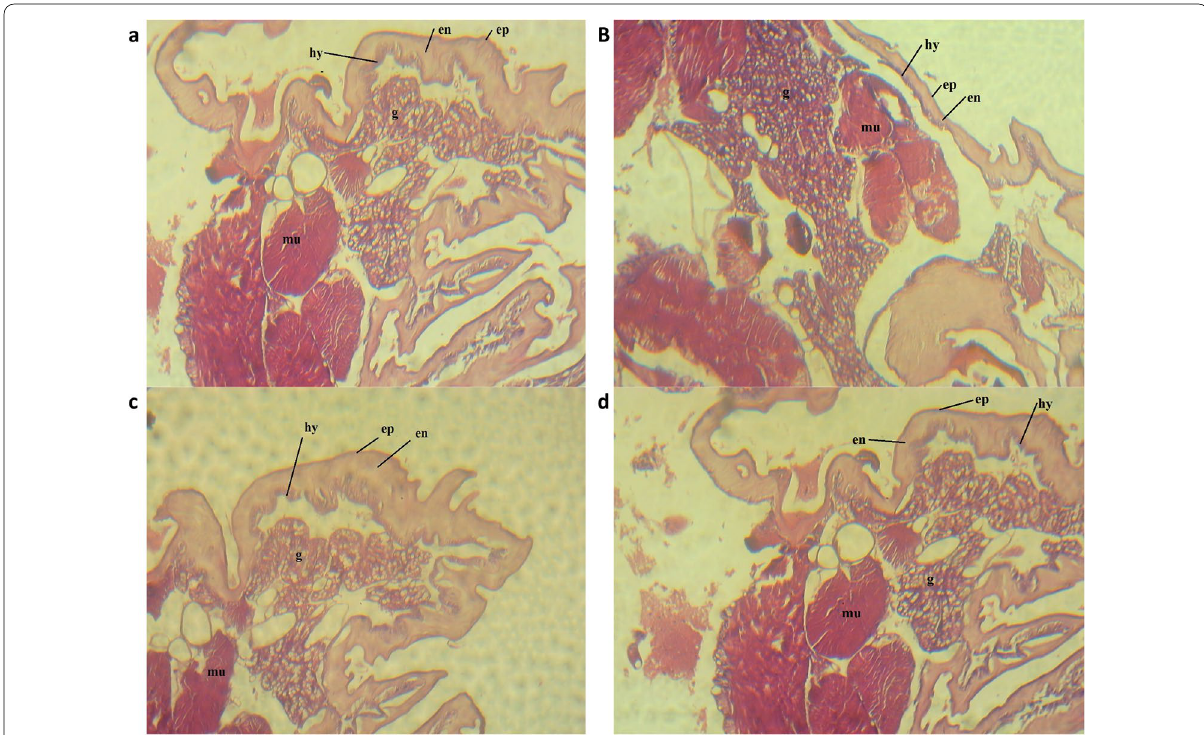
Fig. 2 Photomicrograph of T.S. in the cuticle of the late sixth instar larvae of Spodoptera littoralis showing the structure of larval cuticle: a the normal, b EMB treatment, c AgNPs treatment, and d EMB AgNPs treatment (ep: epicuticle, en: endocuticle, hy: hypodermis, mu: muscle, g: + cytoplasmic granules)